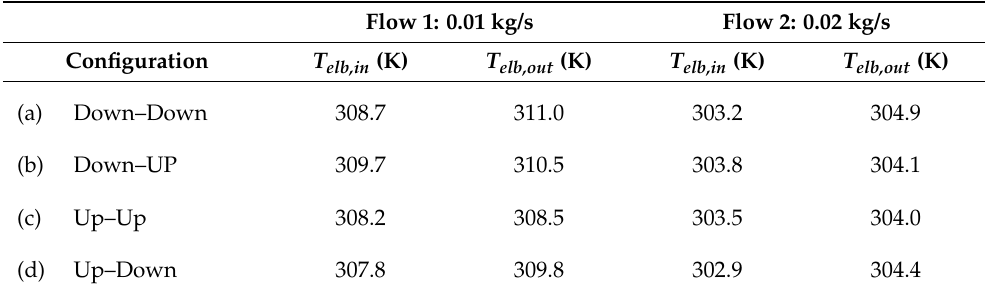
Table 6. Air temperatures in the elbow inlet and outlet of the U-shape double-pass